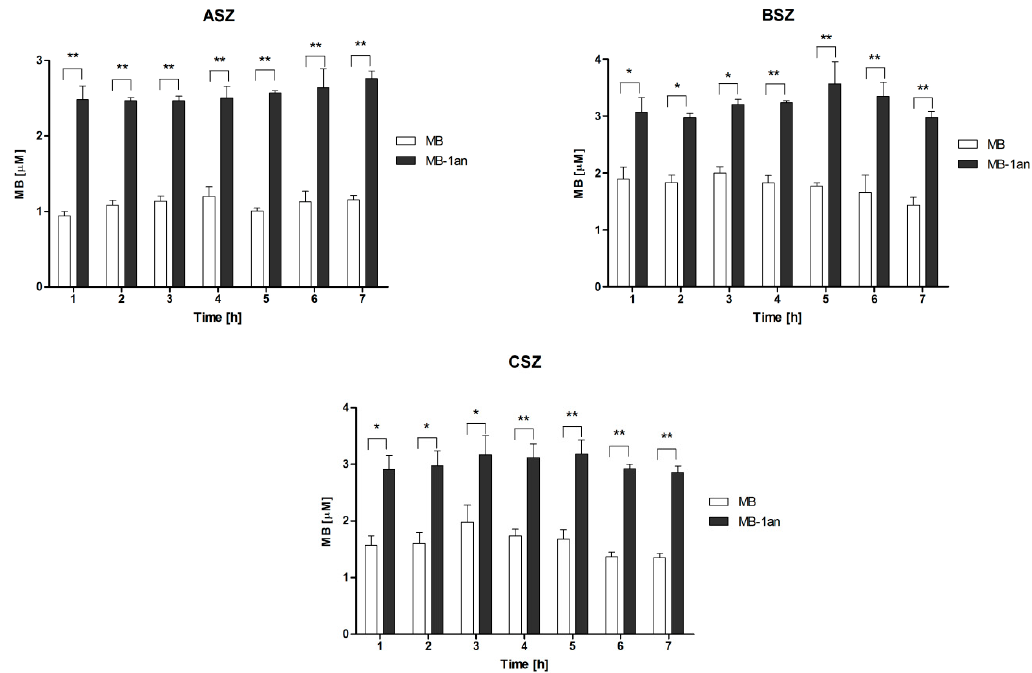
Figure 2. Cellular uptake of MB and MB-1an for ASZ, BSZ, and CSZ cell line, after incubation times from 1 up to 7 h. The concentration of MB was equal to 5 µ M and the dendrimer concentration was 1 µ M. Molar ratio of the complex (MB:1an = 5:1),. * p < 0.05, ** p <